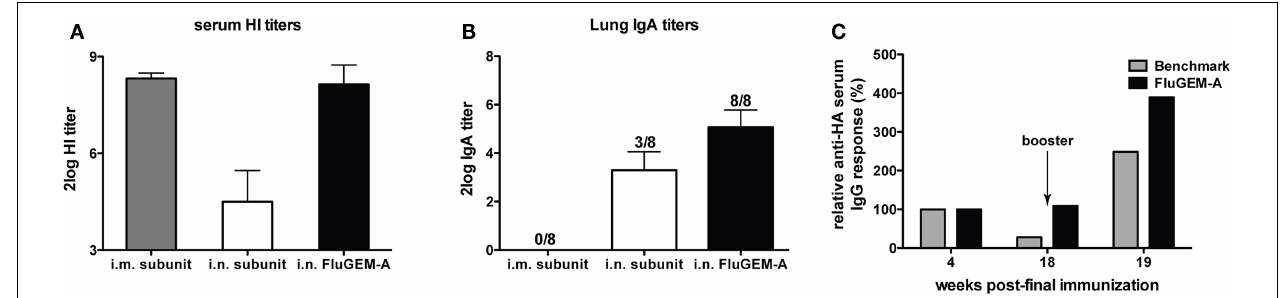
vaccine, and higher in comparison to titers induced by i.n. administration with subunit vaccine. S-IgA titers in lung washes (B) were measured in all the mice vaccinated i.n. with FluGEM-A, while only three mice from i.n. subunit group and none of the mice from i.m. subunit group had detectable lung S-IgA titers. Serum IgG titers (C) induced by i.n. vaccination with FluGEM-A remained stable throughout the 18-weeks post-immunization follow-up period and were still